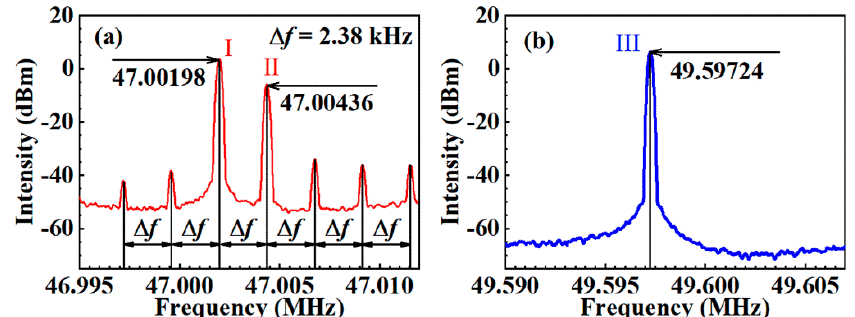
Figure 3. The radio frequency (RF) spectral characteristics of the generated tri-comb with dual-comb and single-comb output from sub-ring 1 and sub-ring 2, respectively. ( a ) RF spectrum of sub-ring 1 and ( b ) RF spectrum of sub-ring 2.